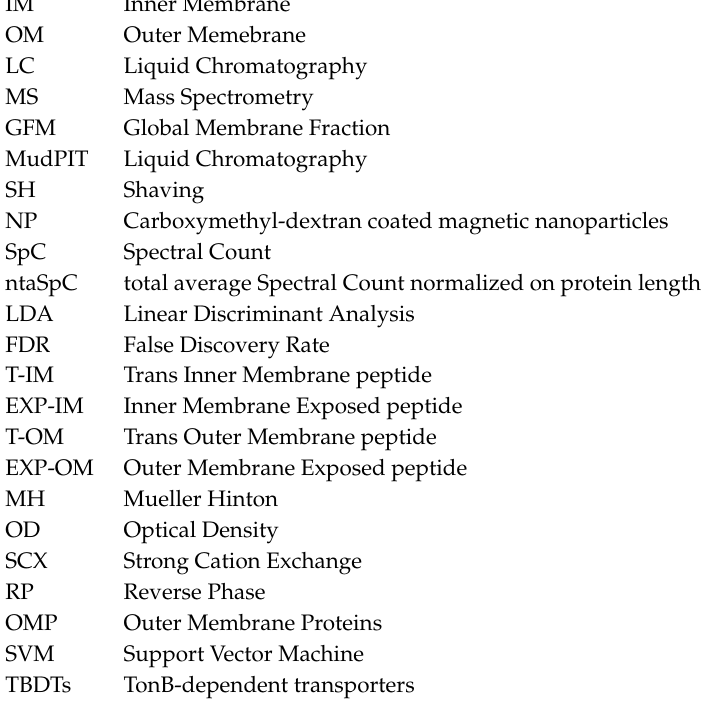
Figure S1: Predominant conformer of oprF, Table S1: Proteins identified by analyzing P. aerugnosa cells treated by IM ( n = 6), OM ( n = 5), GFP ( n = 6), NP ( n = 6), SH ( n = 6) protein extraction methods, Table S2: Cellular components associated with the P. aeruginosa membrane proteome characterized by IM, OM, GFP, SH and NP extraction methods, Table S3: Molecular functions associated with the P. aeruginosa membrane proteome characterized by IM, OM, GFP, SH and NP extraction methods, Table S4: Biological processes associated with the P. aeruginosa membrane proteome characterized by IM, OM, GFP, SH and NP extraction methods, Table S5: Classification of experimentally identified peptides in trans inner membrane (T-IM), inner membrane exposed (EXP-IM), trans outer membrane (T-OM) and outer membrane exposed (EXP-OM), Table S6: Classification of experimentally identified peptides for proteins localized in P. aeruginosa plasma membrane, Table S7: Prediction of epitopes putatively bound and processed by T cell MHC Class I (NetMHCpan 4.1 and MHC-I Processing Predictions) and Class II (MHC-II binding predictions and